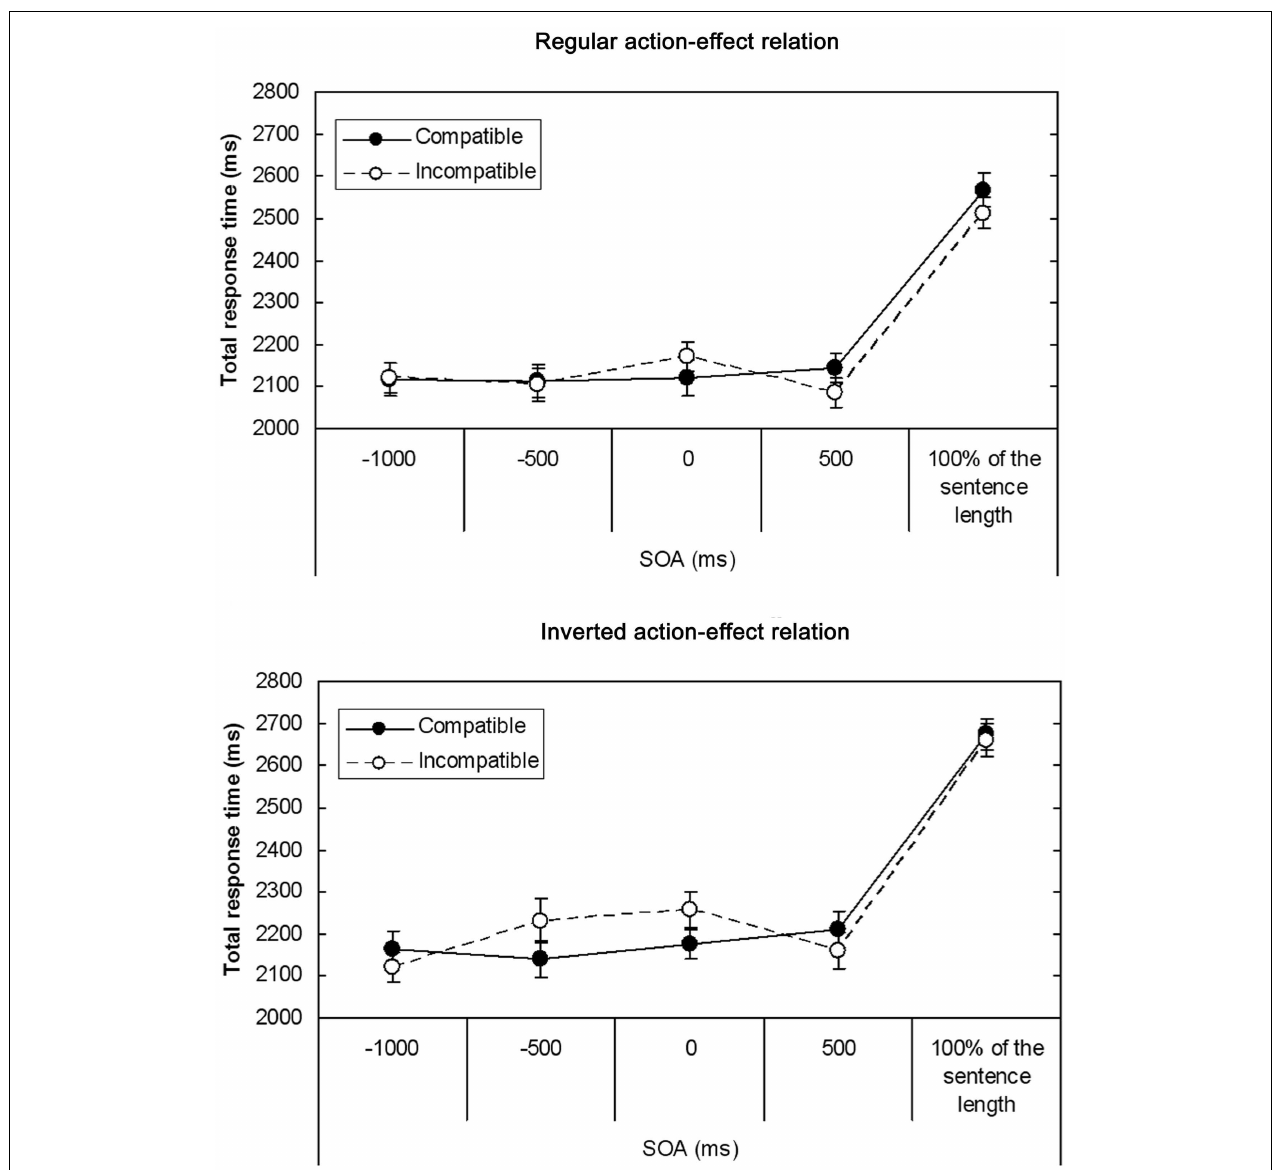
FIGURE 4 | MeanTRTs (in ms) in Experiment 2 as a function of Sentence-effect compatibility, SOA, andAction-effect relation (top panel: regular action-effect relation; bottom panel: inverted action-effect relation) . Data are averaged over concrete and abstract sentences. Error bars represent standard